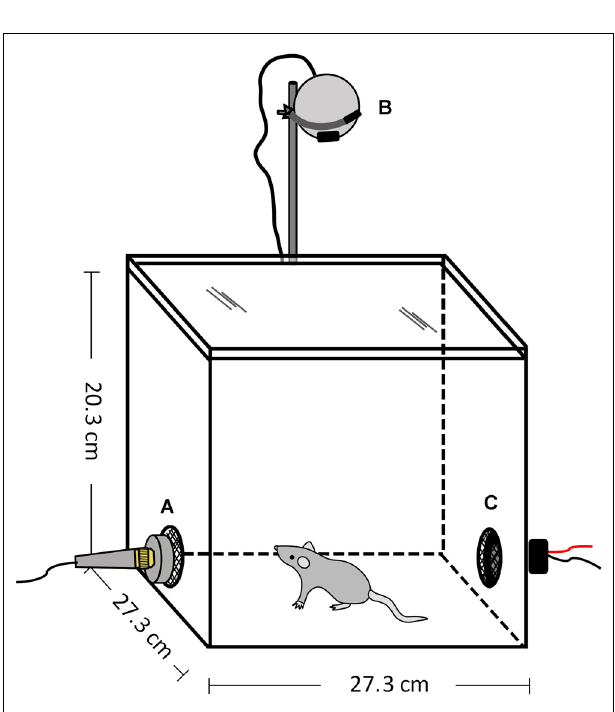
FIGURE 3 | Open field arena to assess responses to vocalization playback. (A) Microphone, (B) Video camera, (C)